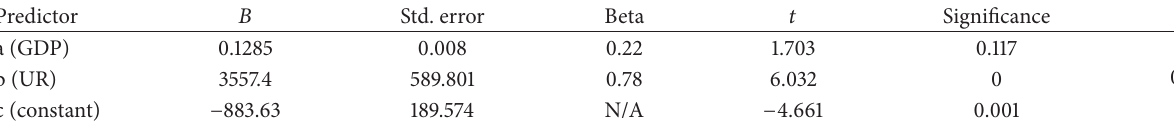
Table 2: Binary linear regression result of model (iii).